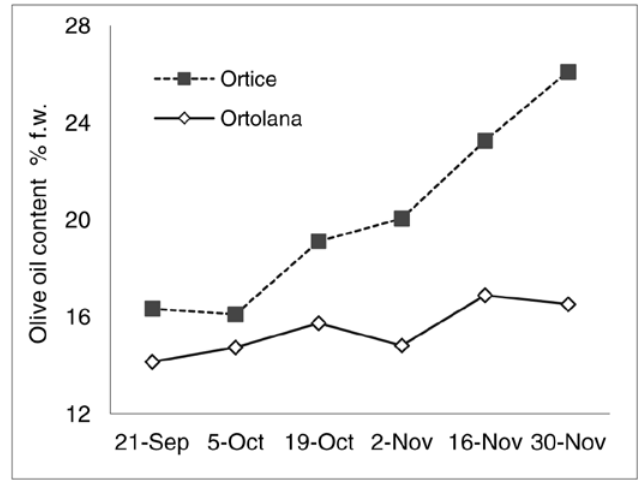
maturation.Fig. 4 - Evolution of olive oil content (% f.w.) during